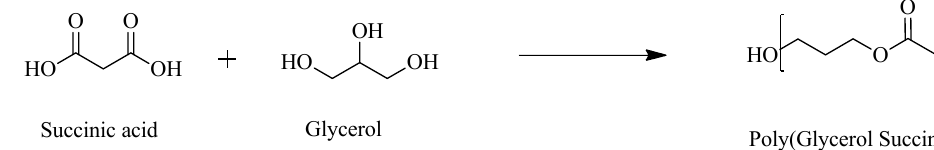
Figure 1. Reaction of succinic acid with glycerol.